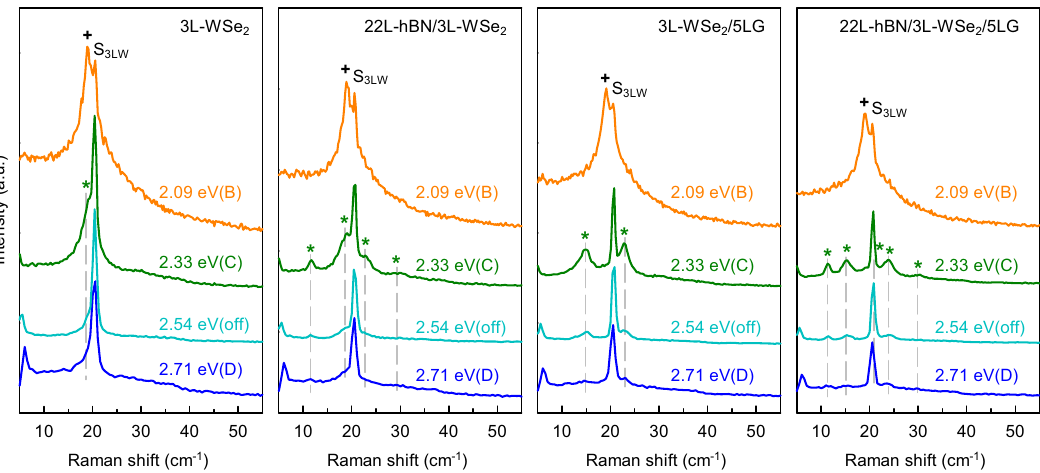
Fig. 2 Intensity resonances of LB modes in hBN/WSe 2 /Gr vdWH and its constituents. LF Raman spectra of 3L-WSe 2 , 22L-hBN/3L-WSe 2 , 3L- WSe 2 /5LG, and 22L-hBN/3L-WSe 2 /5LG excited by four E ex . The E ex corresponding to B, C, and D exciton energies of 3L-WSe 2 are labeled in brackets. The stars indicate the LB modes and the crosses show TA phonon in WSe 230 magic angle 12 : twisting forms periodic charge density and declines the interlayer shear coupling for a small displacement, while the mean charge densities are almost unchanged and keeps the interlayer breathing coupling comparable to that at Bernal- stacked interface. The charge density at the heterointerfaces of extended LB modes. Therefore, the emergence of additional LB coupling in ternary vdWHs.